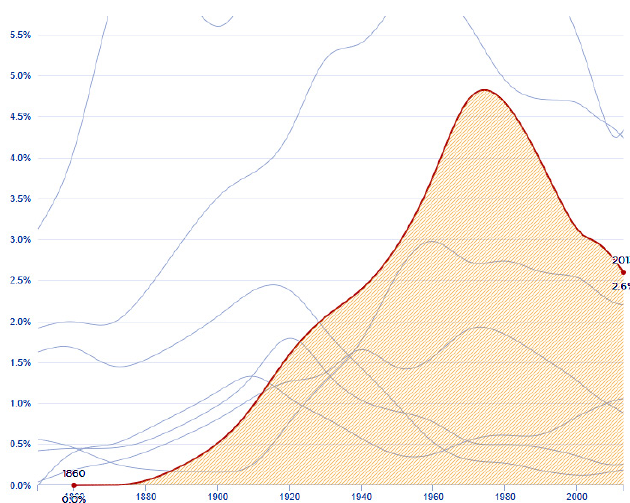
Figure 3. Demand for secretaries